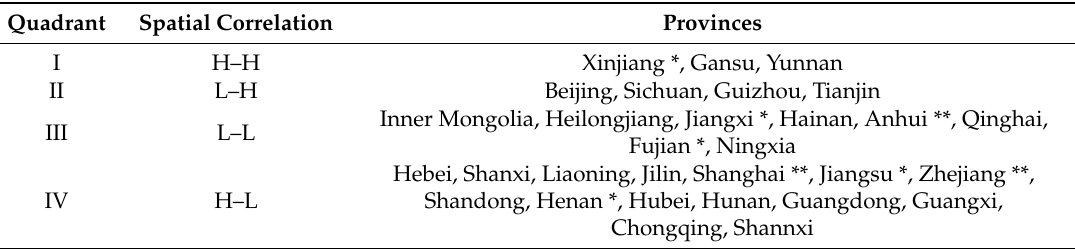
Table 5. Spatial correlation of decoupling index in 30